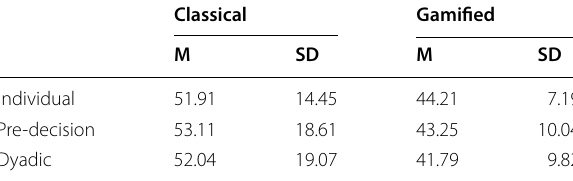
Table 2 Descriptive Statistics: percentage of SS choices in